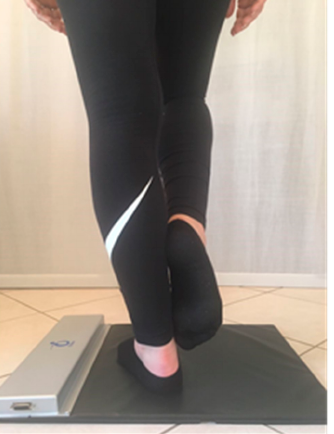
Figure 1. Monopodalic position.